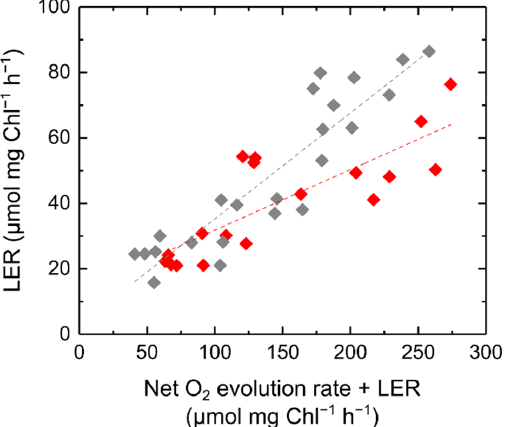
Figure 3. Light-enhanced respiration (LER) at different illumination times in Synechocystis sp. PCC 6803 adapted to the darkness for 24 h (10 µg Chl mL − 1 ). ( A ) Net O 2 evolution rate (black circles) and LER (red diamonds) by the illumination with a red actinic light (190 µmol photons m − 2 s − 1 ). ( B ) Comparison of the total photosynthetic O 2 evolution rate (black circles) defined as the sum of net O 2 evolution rate and LER with effective quantum yield of photosystem II, Y(II) (green squares). Data are shown as the mean with the standard deviation ( n = 4, biological replicates).